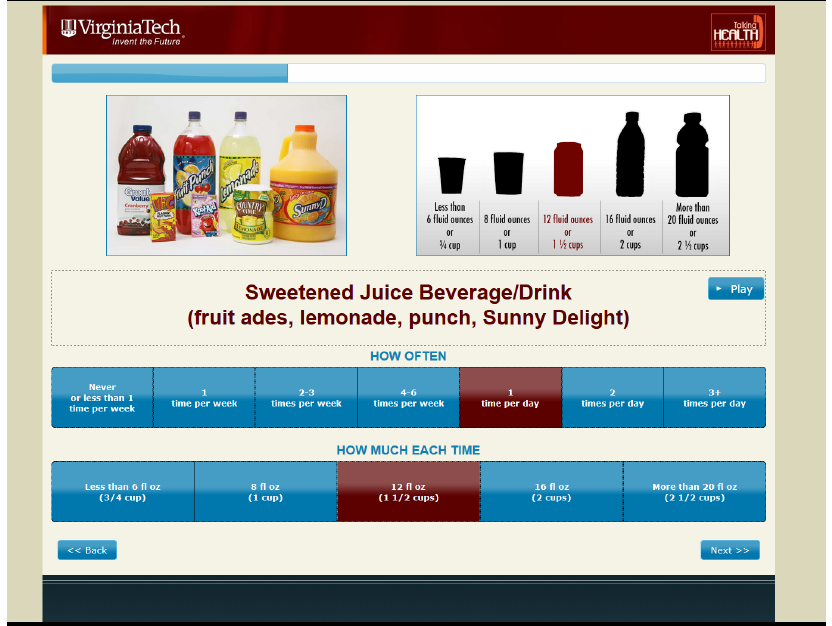
Figure 1. Screenshot example of the sweetened juice drink beverage category from the interactive multimedia beverage intake questionnaire (IMM ‐ BEVQ ‐ 15).